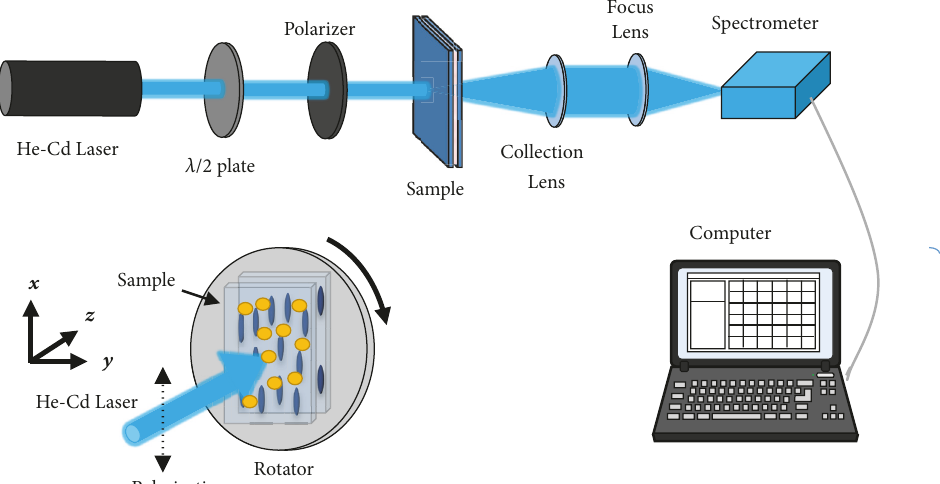
Figure 1: Experimental setup for measuring the PL spectra of the enhanced photoluminescence in GNPs doped homogeneous planar NLCs.